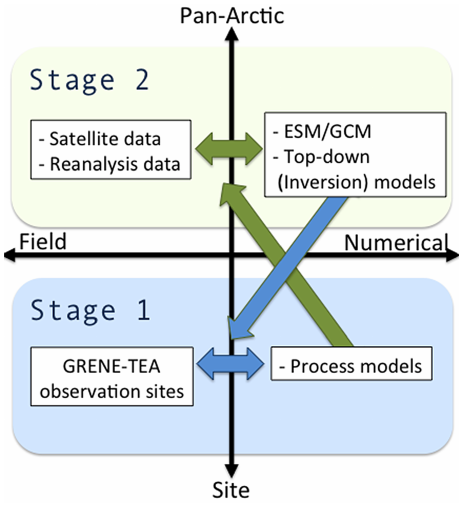
Figure 2. Schematic diagram for stages 1 and 2 of GTMIP.